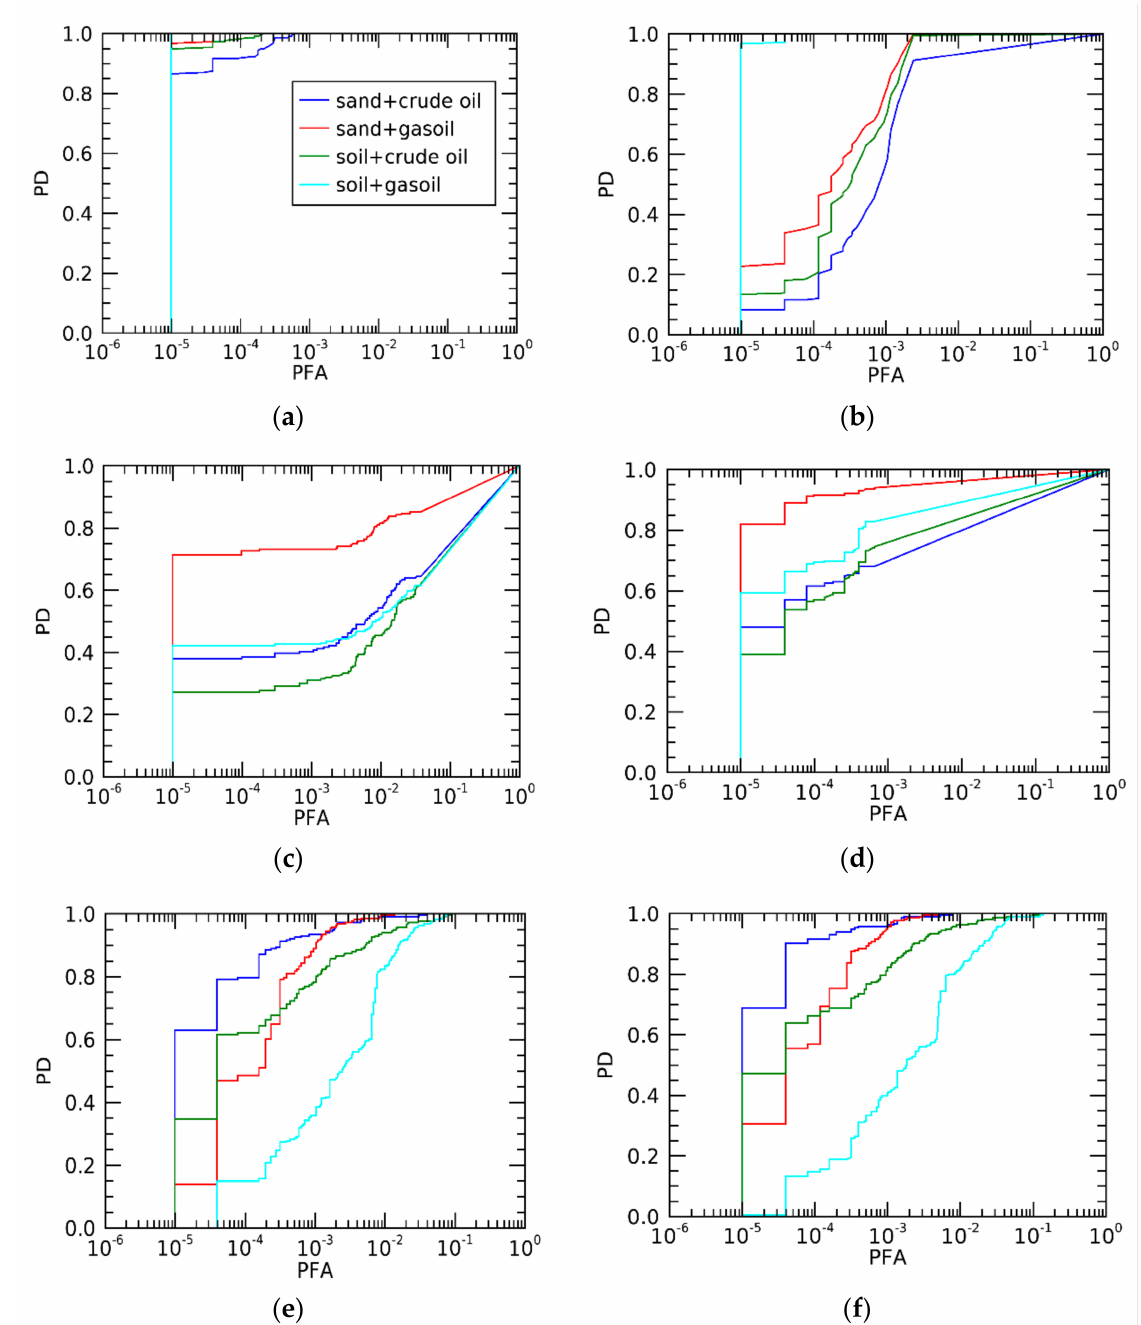
Figure 5. Receiver Operating Characteristic (ROC) curves computed for LRX with ( a ) IWR = 5 and ( b ) IWR = 11; ( c ) Area1700 with vegetation rejection; ( d ) Area1700 applied to LRX results (IWR11) without vegetation rejection; ( e ) CRX with 30 classes; ( f ) CRX with 40